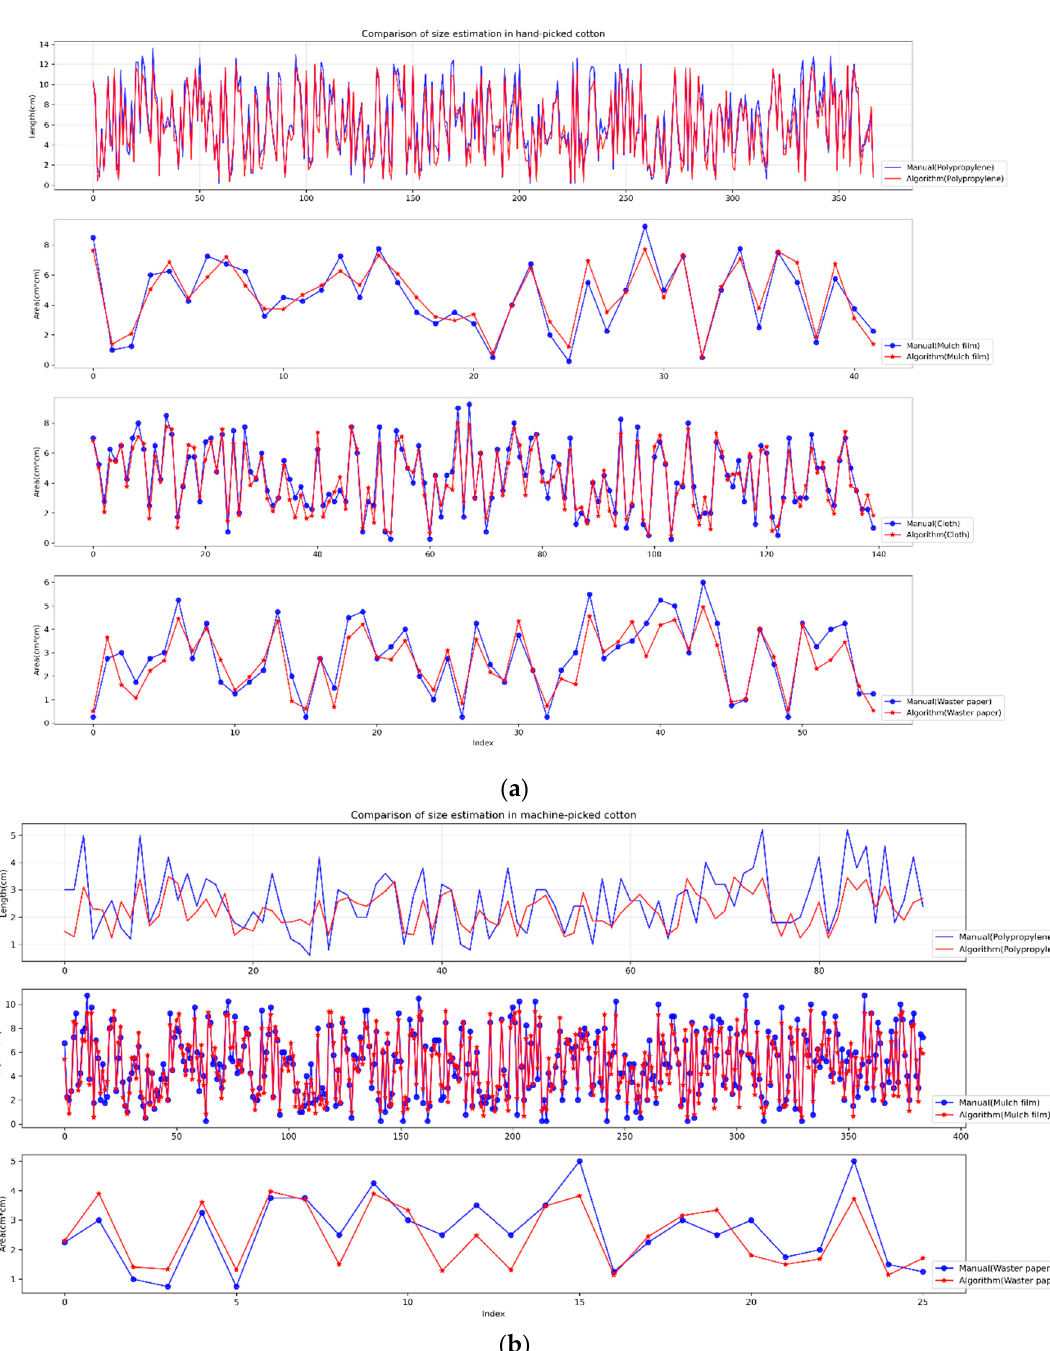
Figure 16. The result distribution of algorithm size estimation and manual calibration. ( a ) Hand-picked cotton ( b ) Machine-picked cotton.